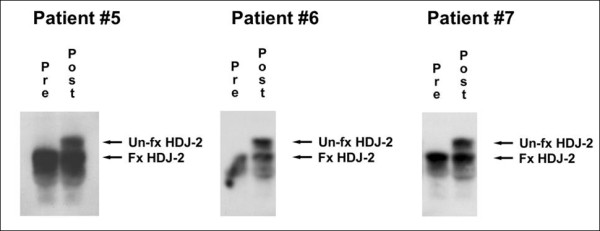
HDJ-2 gel shift in peripheral blood lymphocytes analyzed ex vivo. PBMCs obtained pre-treatment and during week 7 of therapy were analyzed by Western blot for the apparent molecular weight of the farnesylated protein HDJ-2. The appearance of a higher molecular weight band is indicative of a non-farnesylated state.